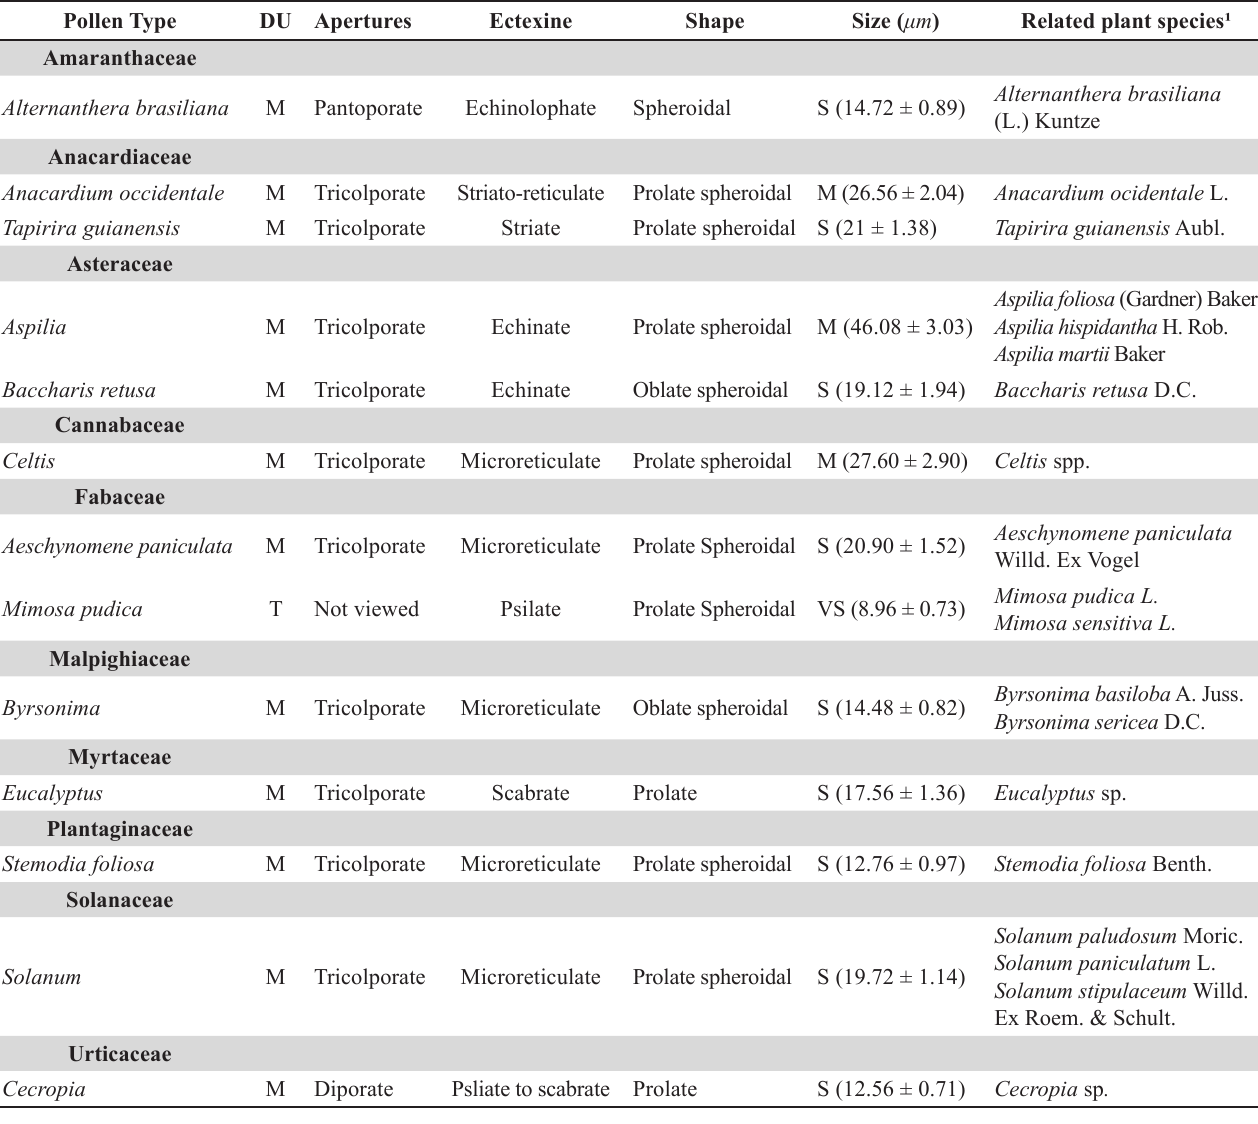
Table 2. Palynological description of the most representative pollen types in the composition of pollen samples stored by Tetragonisca an- gustula (Latreille, 1811) in an area of Atlantic Forest on the northern coast of Bahia. DU (Dispersal unit): M= Monad; T= Tetrad. Size: VS= Very Small; S= Small; M=